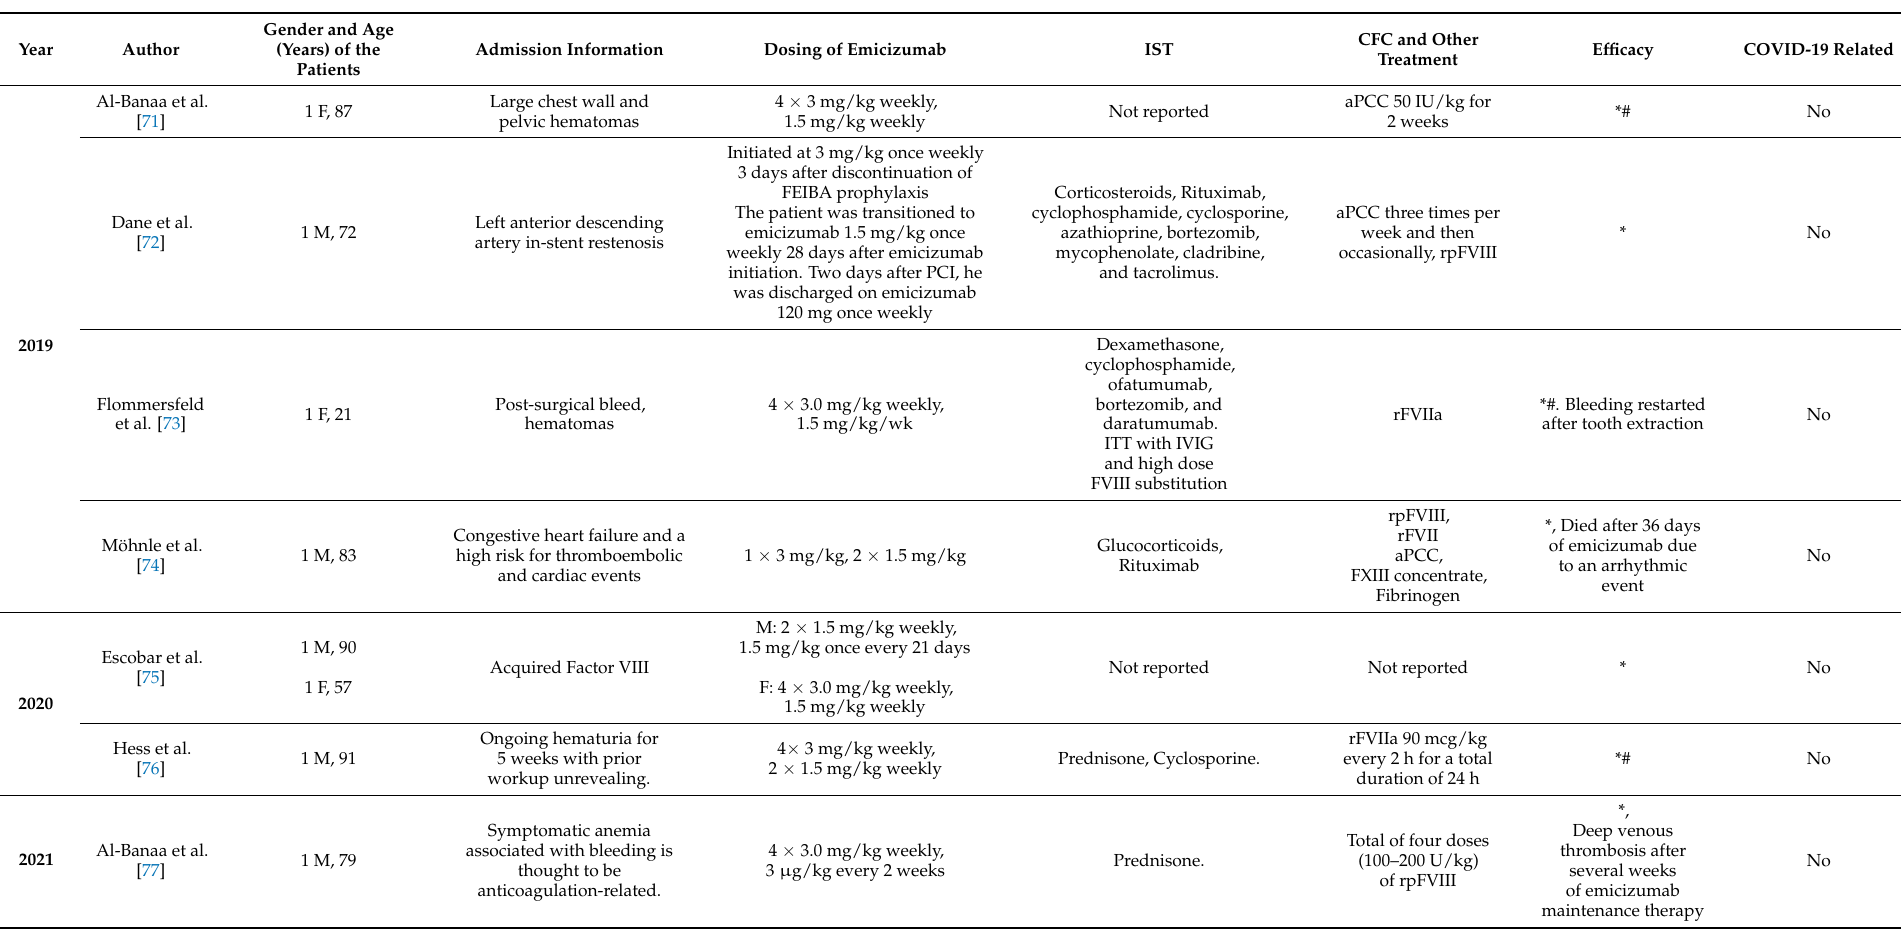
Table 2. Overview of cases of acquired haemophilia A treated with emicizumab therapy. The table reports the patients’ characteristics, admission information, dosing of emicizumab, immunosuppressive therapy (IST), clotting factor concentrate (CFC) and other treatments, the efficacy of the treatment and